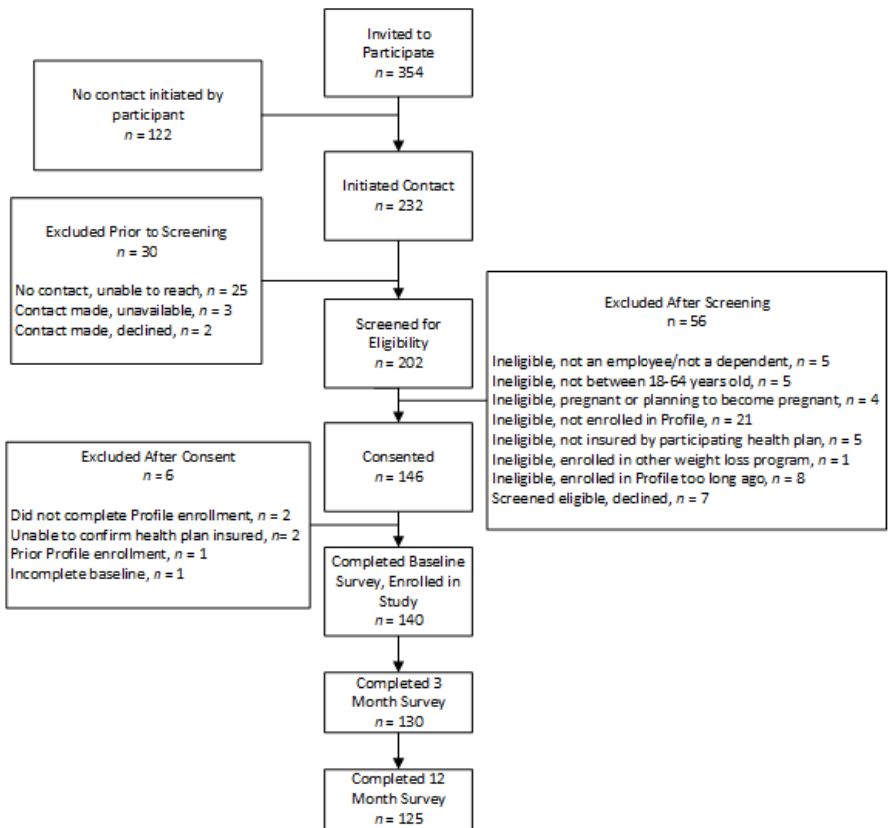
Figure 2. Study flow from program enrollment through study recruitment and data collection.